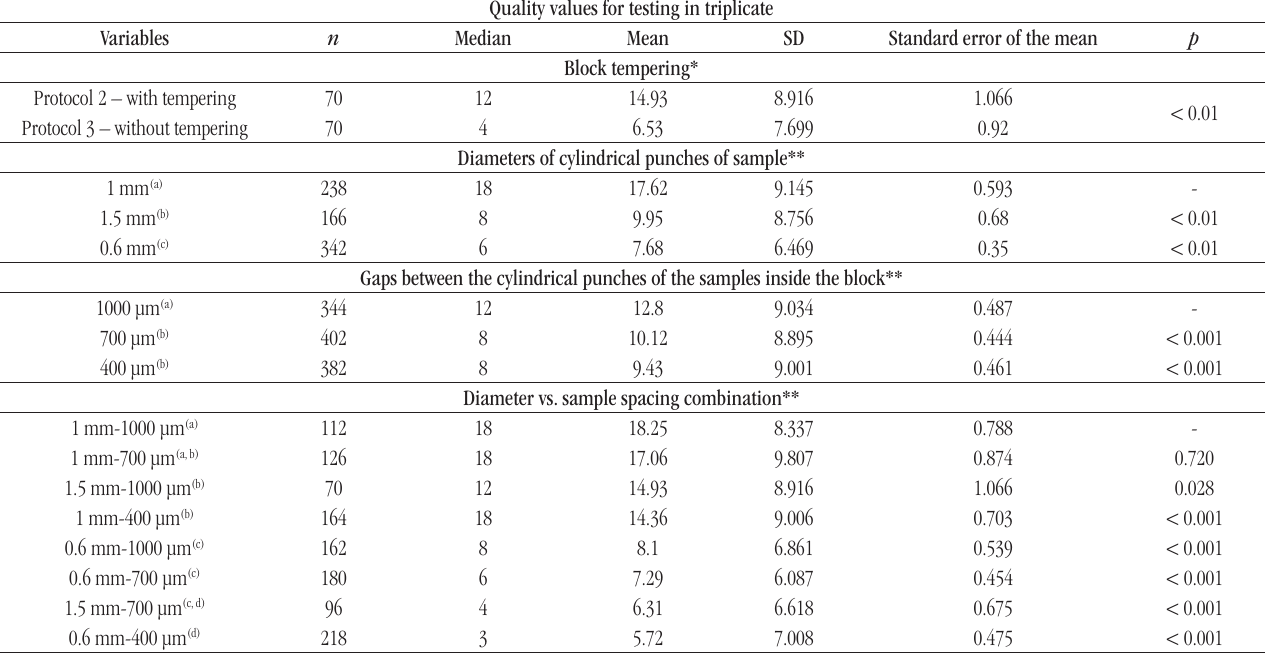
taBLE 1 − Quality of blocks in relation to physical parameters used to construct the TMA Quality values for testing in triplicate Mean SD Standard error of the